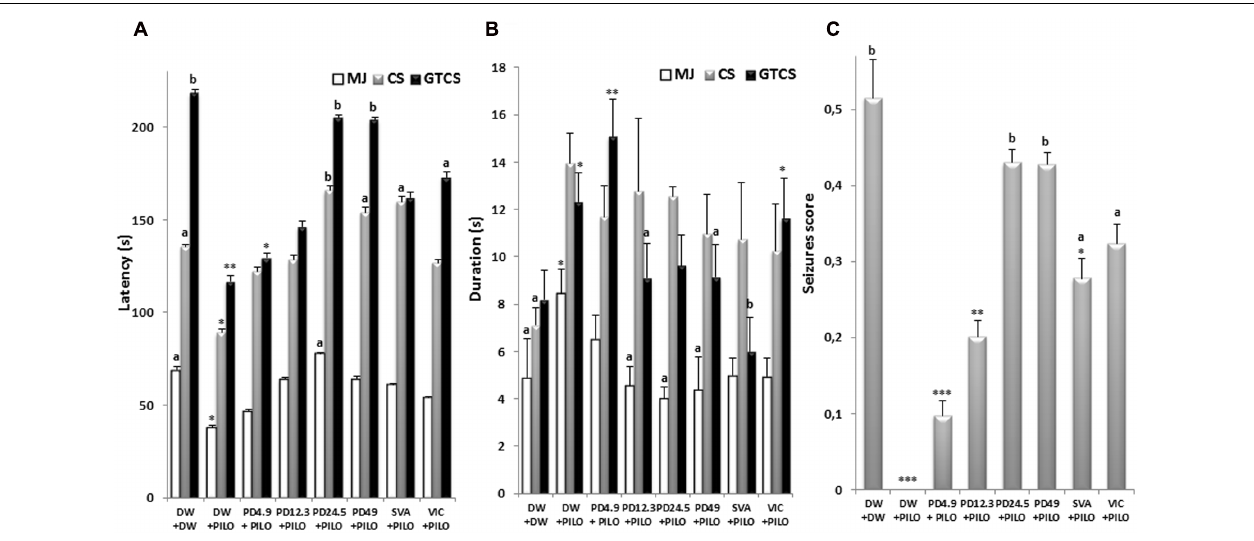
FIGURE 1 | Effect s of P. daemia on PTZ challenge outcome. (A) Effects of P. daemia extract on the latency to myoclonic jerks, clonic seizures and generalized tonic–clonic seizures induced by pentylenetetrazol challenge in pilocarpine-injected mice. (B) Effect of P. daemia extract on the duration of myoclonic jerks, clonic seizures and generalized tonic–clonic seizures in the same animals. (C) Effects of P. daemia on the seizures score. Data are mean ± SEM, N = 7 per group. Newman Keul’s multiple comparisons post hoc test, with Mann–Whitney U test correction: (i) vs. control animals (DW + DW group) receiving only distilled water: ∗ p < 0.05, ∗∗ p < 0.01; (ii) ∗∗∗ p < 0.001 vs. disease control animals (DW + PILO group) receiving distilled water and pilocarpine: a p < 0.05, b p < 0.01. CS, clonic seizures; DW, distilled water; MJ, myoclonic jerks; GTCS, generalized tonic–clonic seizures; PD, Pergularia daemia ; PILO, pilocarpine; VIC, vitamin C; SVA, sodium valproate.